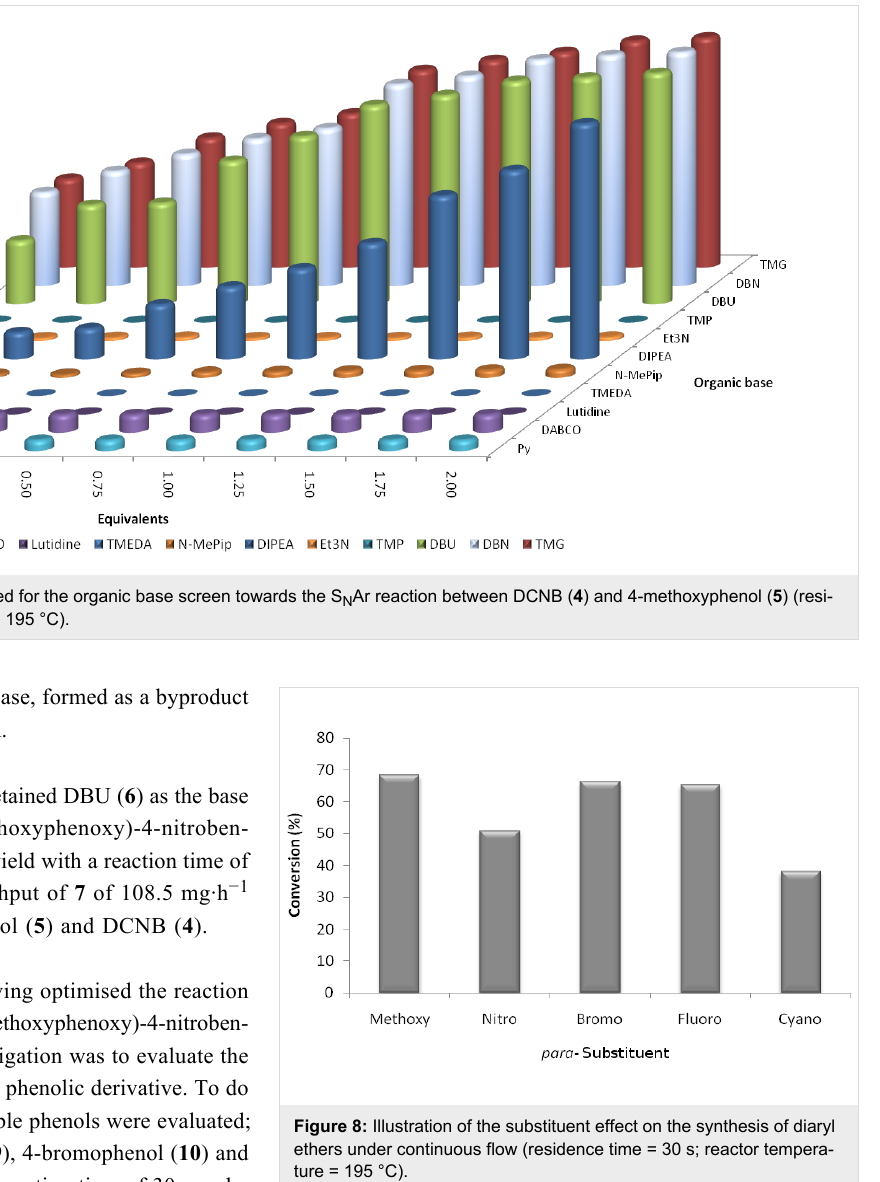
Figure 8: Illustration of the substituent effect on the synthesis of diaryl ethers under continuous flow (residence time = 30 s; reactor tempera- ture = 195